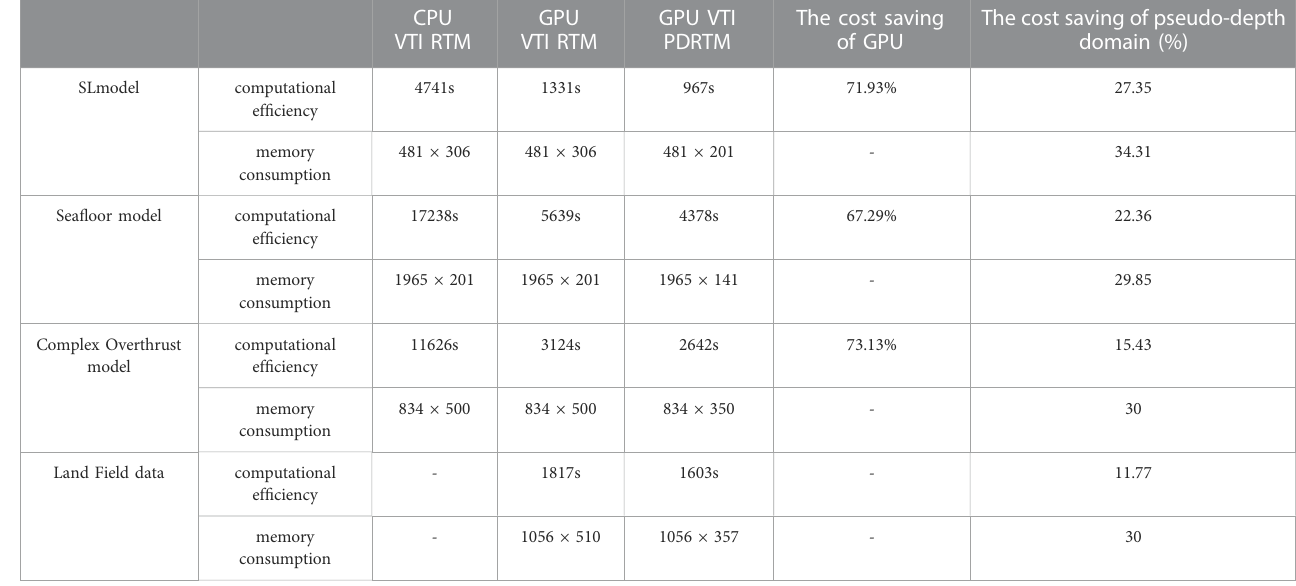
TABLE 2 The calculation ef fi ciency and memory consumption of different migration methods under the same calculation parameters.